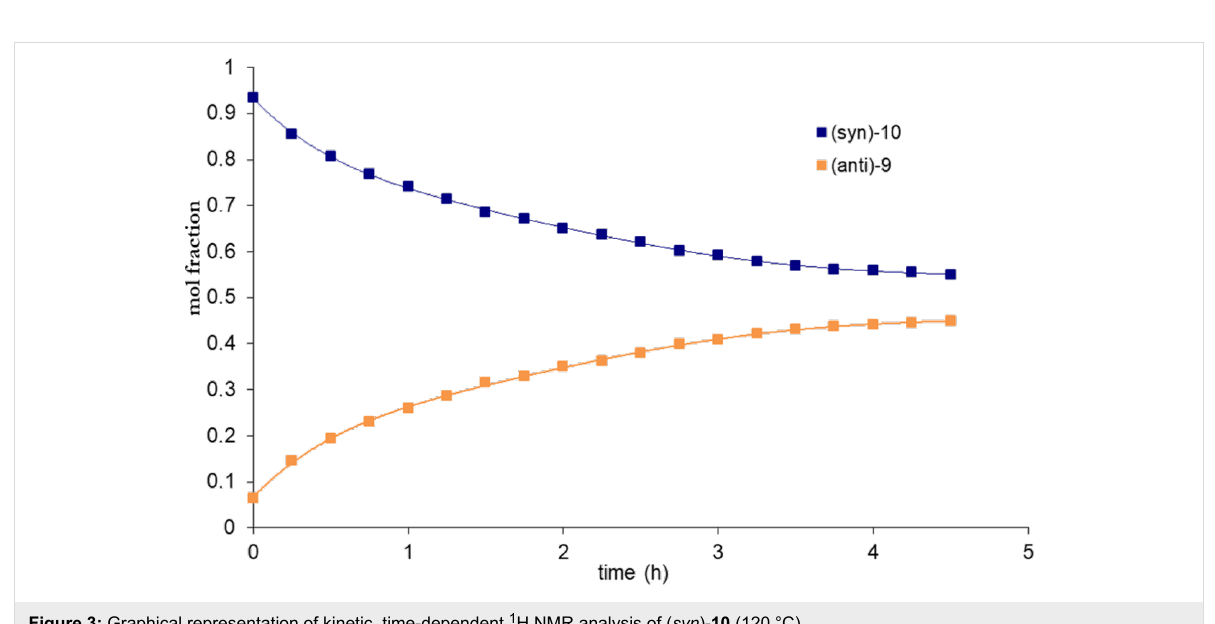
Figure 3: Graphical representation of kinetic, time-dependent 1 H NMR analysis of ( syn )- 10 (120 °C).